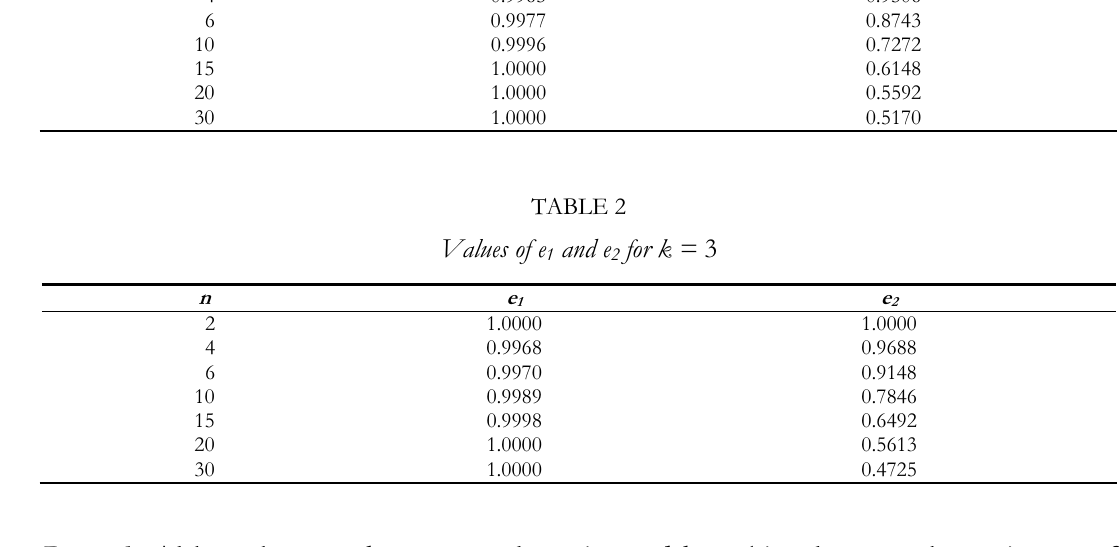
and e for k = 2 1 2